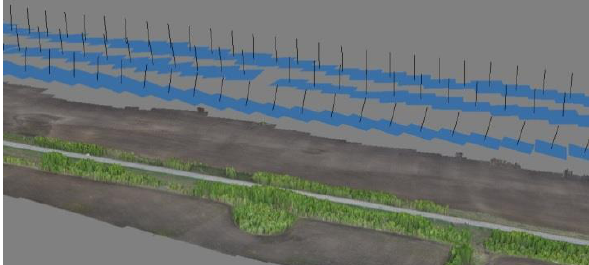
Figure 3. A fragment of a dense DSM with visualization of principal point positions while surveying